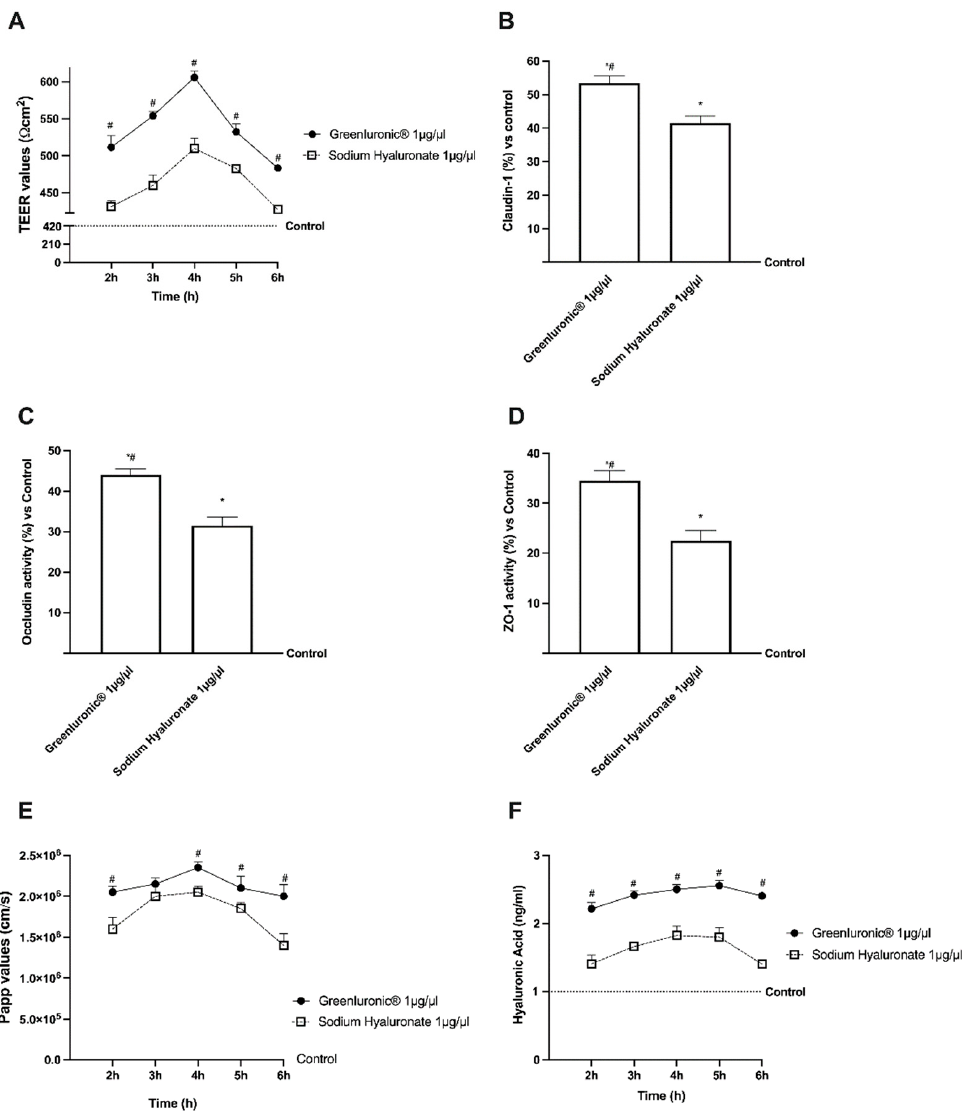
Figure 4. Permeability study on CaCo-2 cells. In ( A ) TEER Value using EVOM3; from ( B – D ) the analysis of TJ measured by Enzyme-Linked Immunosorbent Assay (ELISA) test (Occludin, Claudin1, and ZO-1, respectively); in ( E ) the Papp values in which data <0.2 × 10 − 6 cm/s mean very poor absorption with a bioavailability <1%, data between 0.2 × 10 − 6 and 2 × 10 − 6 cm/s with bioavailability between 1 and 90%, and data >2 × 10 − 6 cm/s mean very good absorption with a bioavailability over 90%. In ( F ) HA quantification measured by ELISA kit. Data are mean ± SD of five independent experiments performed in triplicates. From ( B – D ) means± SD are expressed comparing data to control value (0% line) and * p < 0.05 vs. control; # p < 0.05 vs. Sodium Hyaluronate 1 µg/µL. On the contrary, in ( A , E , F ) the control samples are specifically reported and both GreenIuronic ® and sodium hyaluronate are p < 0.0001 vs. control; # p < 0.05 vs. Sodium Hyaluronate 1 µg/µL.